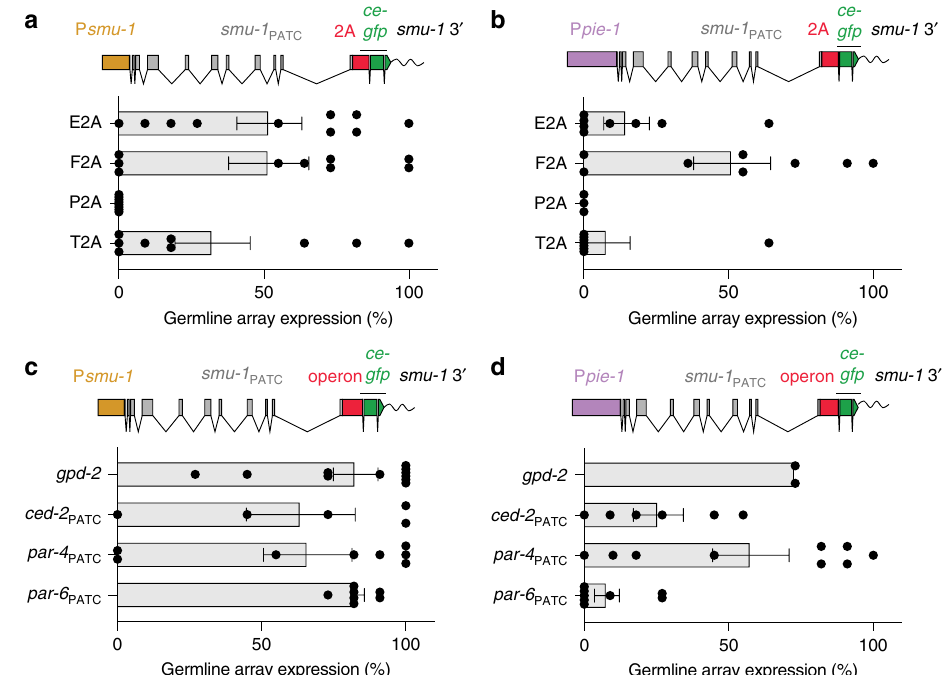
Fig. 4 The effect of viral 2A peptides and operon sequences on germline co-expression of genes. a Germline expression of a ce - gfp fused to a genomic P smu-1 :: smu-1 gene (germline and soma) separated by various viral 2A peptide tags. 2A tags result in ribosomal skipping and peptide cleavage, which allows co-expression of two or more genes from one open reading frame 54 . n = 10, 9, 8, and 9 biologically independent transgenic lines (from top to bottom). b Germline expression of a ce - gfp fused to a genomic P pie-1 :: smu-1 gene (germline-speci fi c) separated by various 2 A peptide tags. n = 8, 8, 3, and 8 biologically independent transgenic lines (from top to bottom). c Germline expression of a ce - gfp fused to a genomic P smu-1 :: smu-1 gene (germline and soma) separated by various operon sequences. Operons are common in C. elegans 55 , particularly for genes expressed in the germline 56 . Operons allow co- expression or more than one gene from a single promoter. n = 11, 5, 8, and 7 biologically independent transgenic lines (from top to bottom). d Germline expression of a ce - gfp fused to a genomic P pie-1 :: smu-1 gene (germline and soma) separated by various operon sequences. n = 2, 6, 9, and 8 biologically independent transgenic lines (from top to bottom). Transgene scale bars = 100 nucleotides. All germline fl uorescence was quanti fi ed from transgenic animals carrying simple extrachromosomal arrays imaged with a ×40 or ×63 oil objective at 25 °C. Each datapoint indicates one independent measurement of germline fl uorescence scored from 11 animals from an independent transgenic line. Bars indicate the mean, and error bars indicate the SEM. Source data are available in the Source Data fi